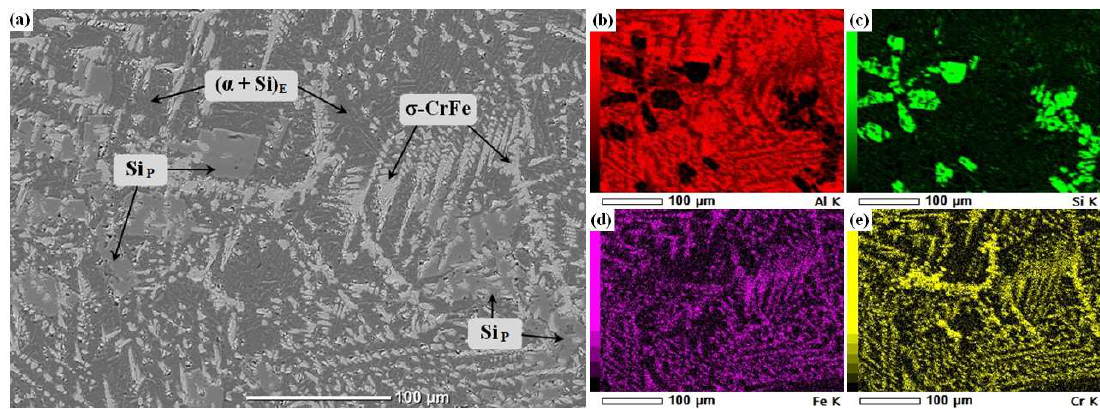
Figure 5. ( a ) Backscattered electron image of AlSiFe with 5 wt. % Cr alloy. Elemental mapping of ( b ) aluminum, ( c ) silicon, ( d ) iron, and ( e ) chromium. Si p = Primary silicon, (α+Si) E = Eutectic.